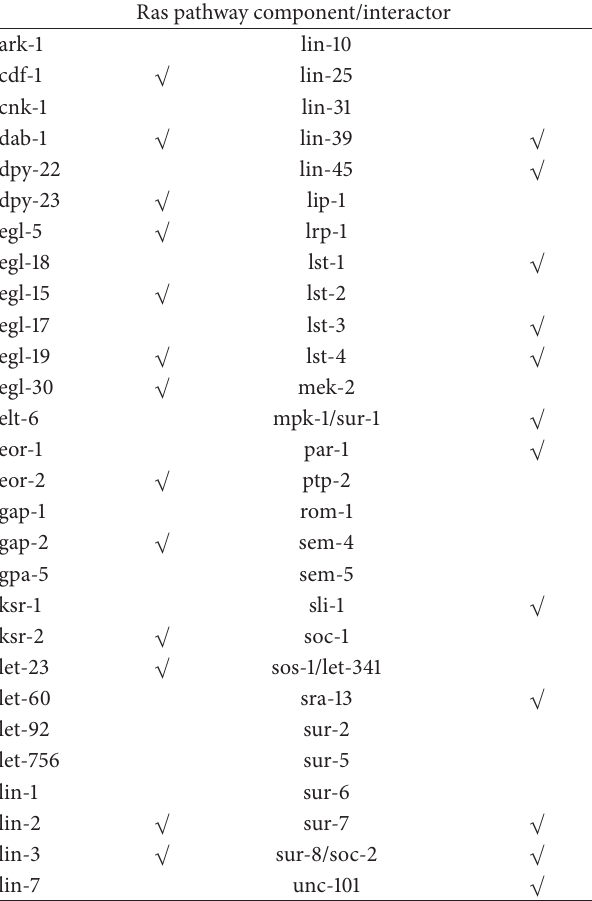
Table 1: Ras pathway components, regulators, interactors, and targets in C. elegans . Those marked with a √ produce 2 or more isoforms differing by at least 1 alternative exon (according to [4,